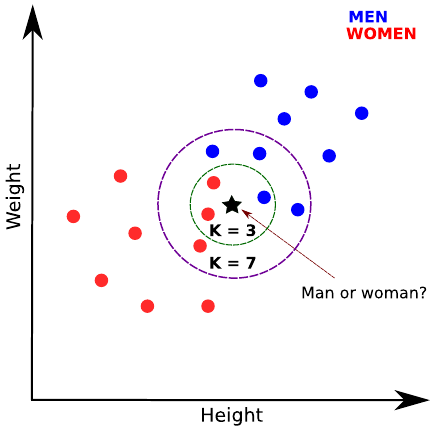
Figure 2. Classification based on different values of K